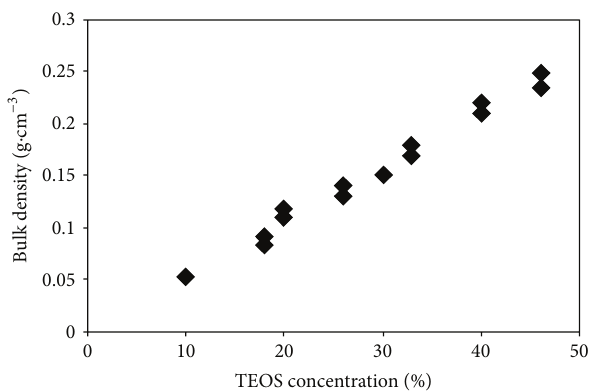
Figure 2: Control of the aerogel bulk density by the TEOS concen- tration.